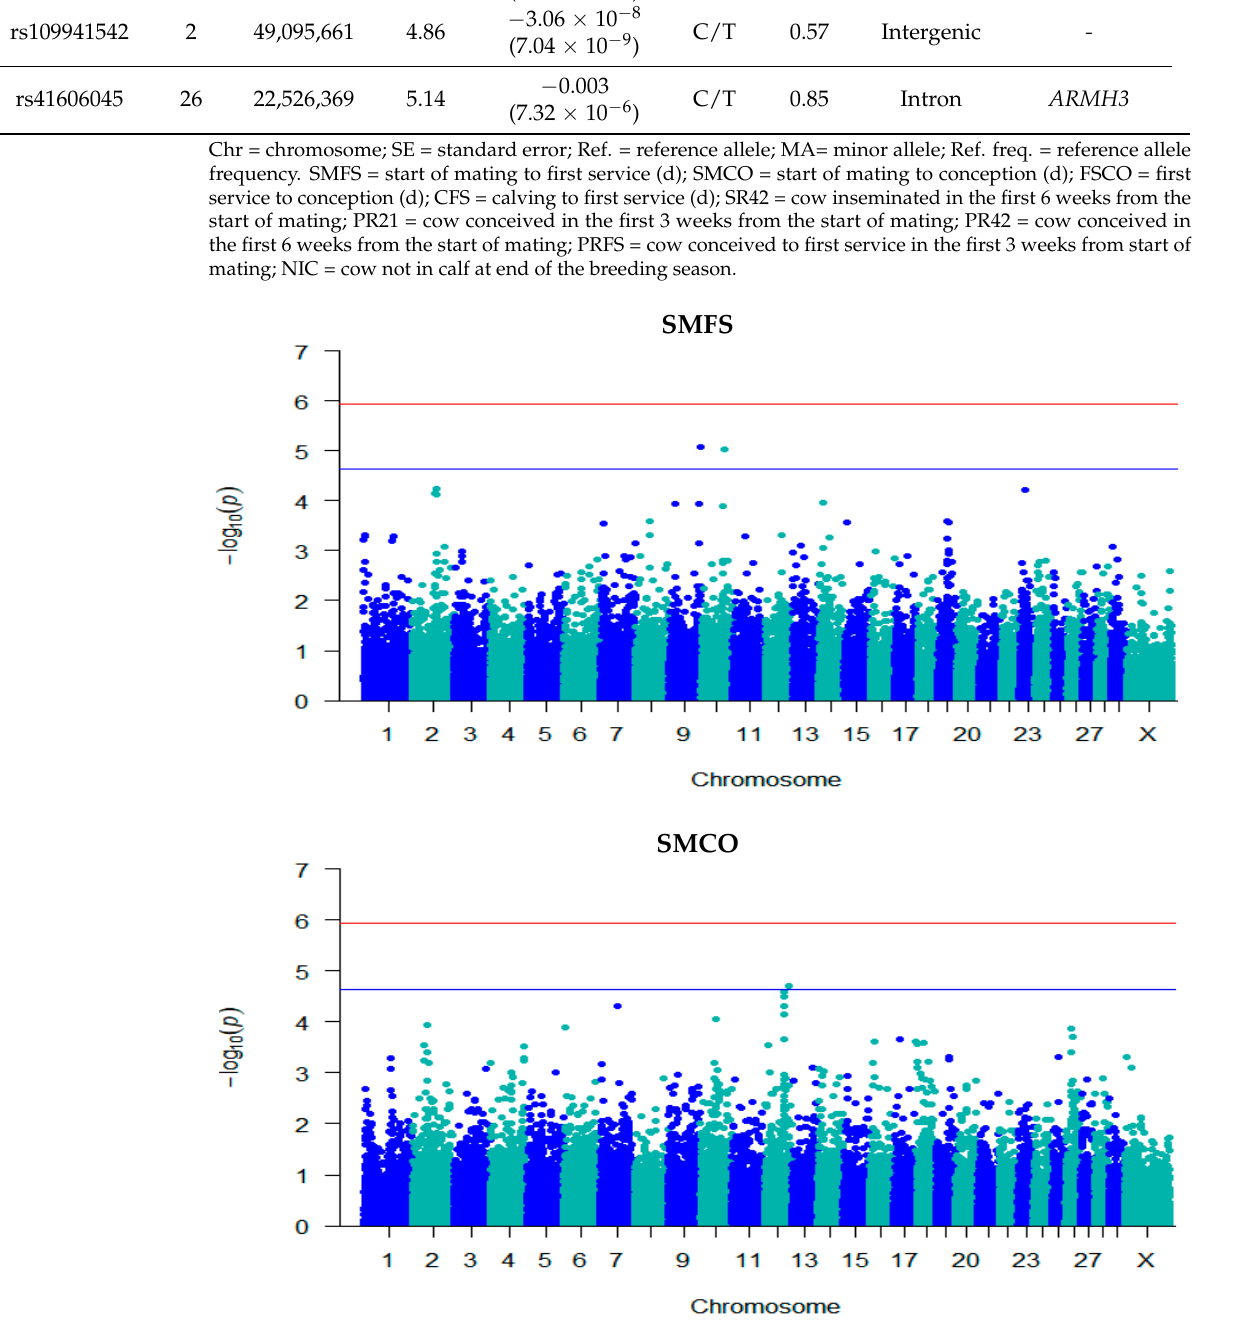
FSCO Figure 2. Cont